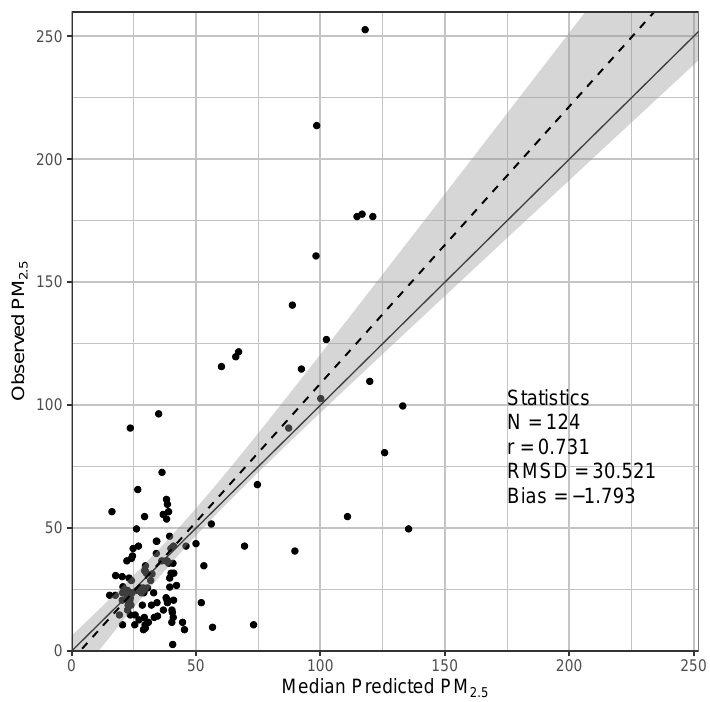
Figure 5. Predicted vs. observed PM 2.5 from 1000 iterations of Support Vector Machine regression applied to 74 MISR AOD mixtures. Linear regression (dashed line) with 95% confidence band (gray shading) and 1-to-1 line (solid line) shown with corresponding